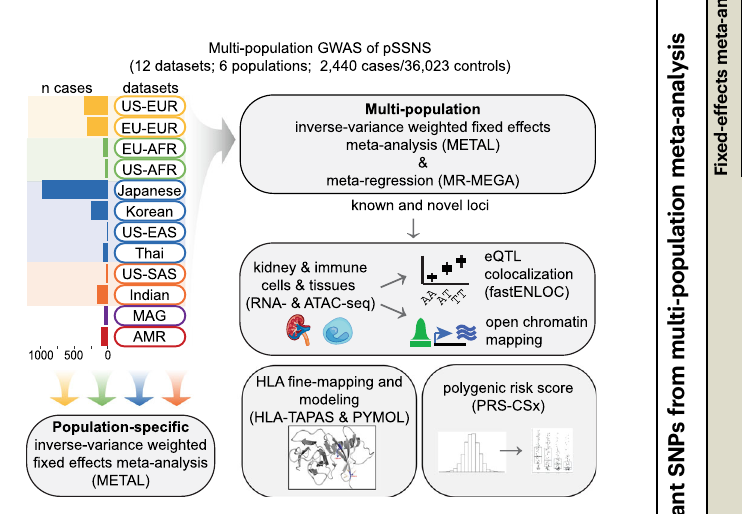
Fig.1|Flowchartofstudydesign. 12datasetsacrosssixpopulationswereusedfor population-speci fi c and multi-population GWAS meta-analyses. The population assignment and number of cases for each dataset are indicated (yellow=European (EUR), green=African (AFR), blue=East Asian (EAS), orange=South Asian (SAS), purple=Maghrebian (MAG), red=Admixed American (AMR)). Post-GWAS analyses includecolocalization with both kidneyand immune eQTL datasets and